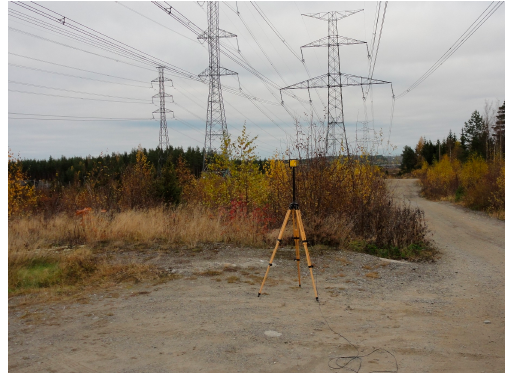
Figure 2. Electric field measurement at experiment location.